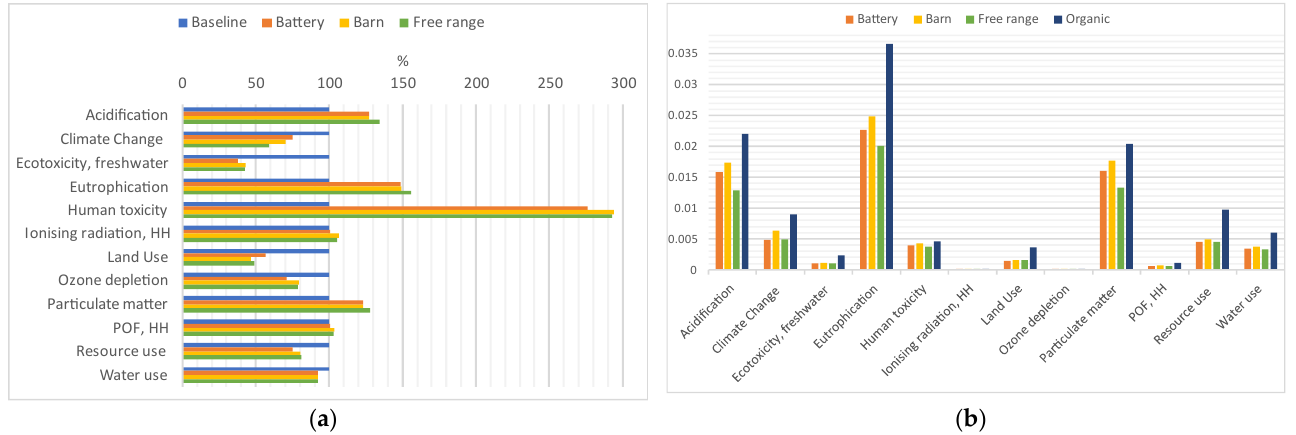
Figure 6. Potential reduction in impact categories if conventional feed is replaced by organic feed using Environmental Footprint 3.0, for one kilogram of eggs: ( a ) for battery, barn, and free-range compared to the baseline; ( b ) normalized and weighted results for battery, barn, and free-range compared to organic eggs.